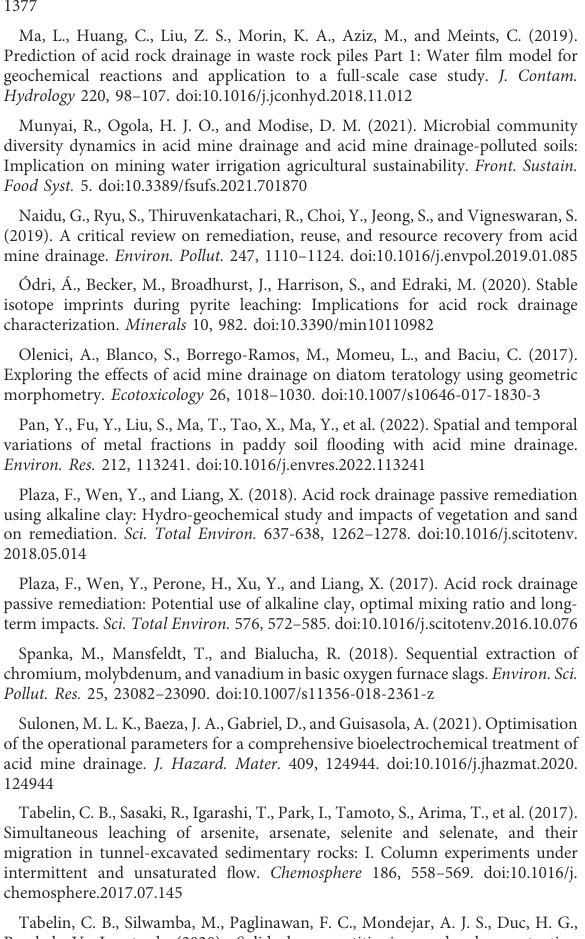
Tabelin, C. B., Silwamba, M., Paglinawan, F. C., Mondejar, A. J. S., Duc, H. G., Resabal, V. J., et al. (2020). Solid-phase partitioning and